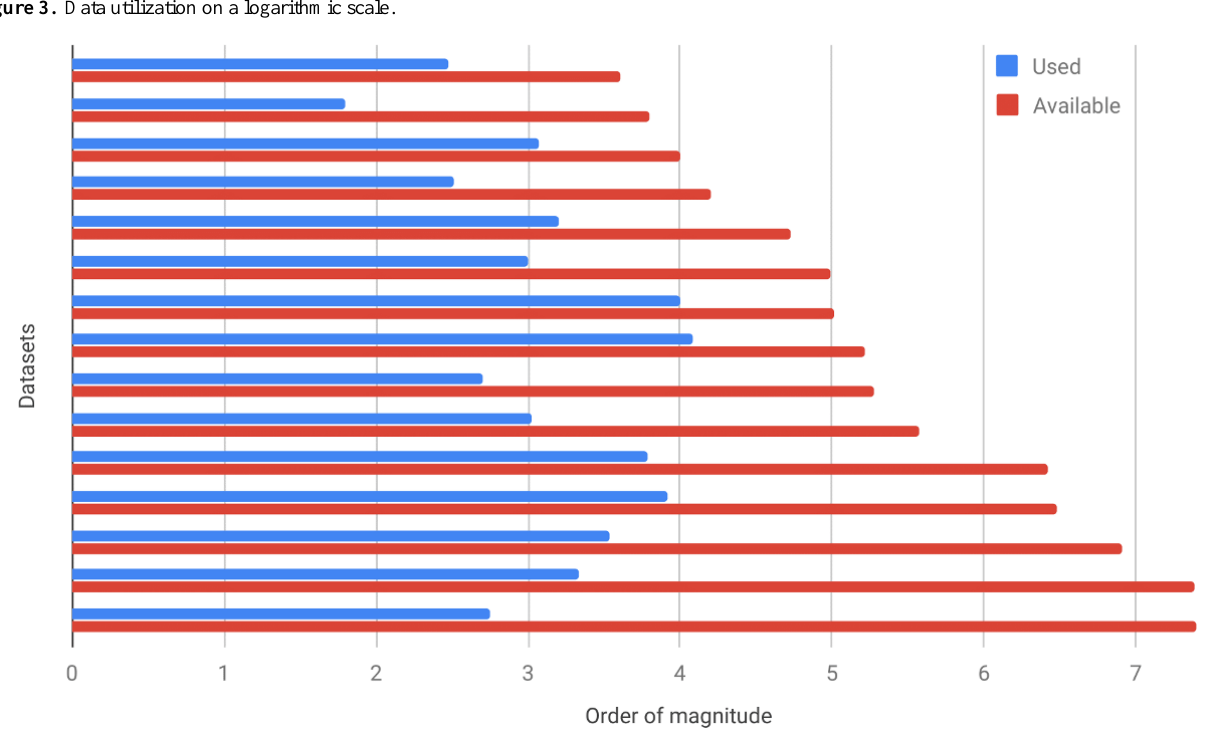
Figure 3. Data utilization on a logarithmic